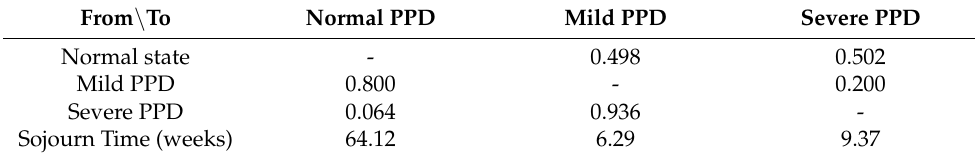
Table 3. PPD state transition probabilities.